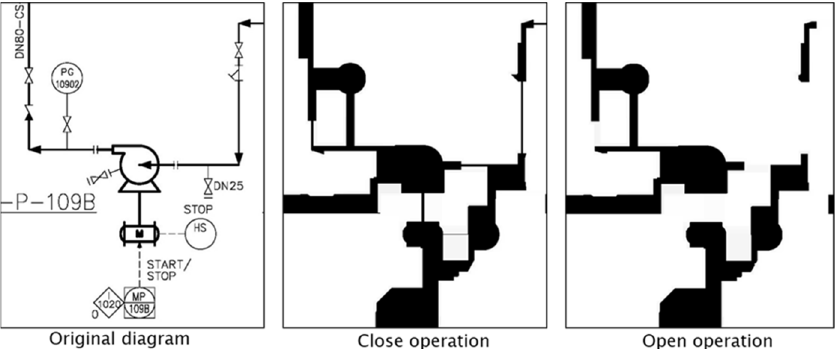
Figure 6. Identification of regions in a diagram where the symbols possibly exist.